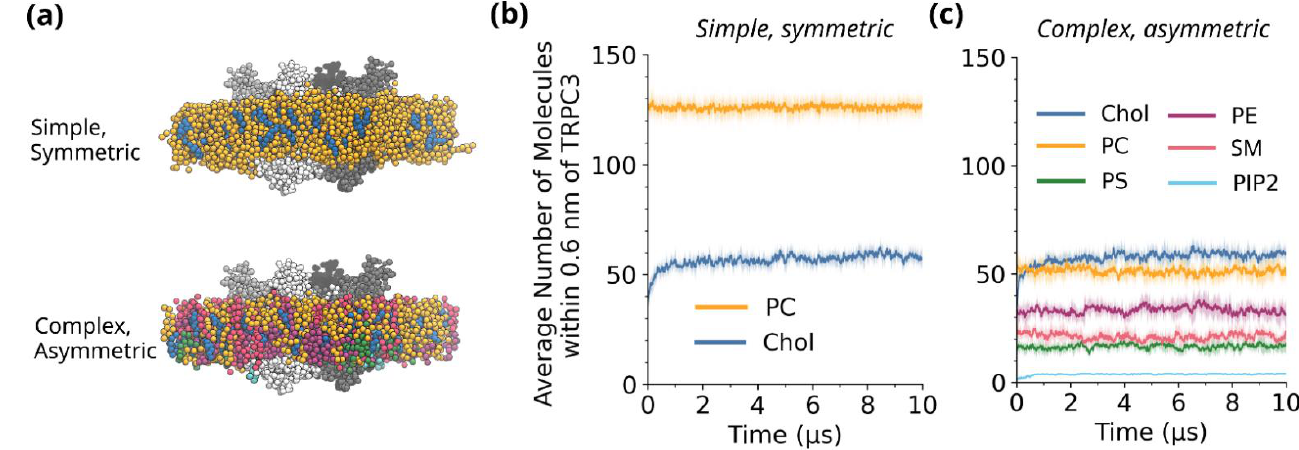
Figure 1. ( a ) Representative examples of the two membranes used in this study, a two-component symmetric membrane ( top ) and a six-component asymmetric membrane ( bottom ). The TRPC3 homotetramer is shown in greyscale, whilst the lipids are coloured according to the scheme in ( b , c ). ( b , c ) Number of lipid molecules within 0.6 nm of the TRPC3 homotetramer as a function of time, for the symmetric ( b ) and asymmetric ( c ) membranes. In dark is the mean averaged across four repeats; in light is the standard deviation. A window average of 20 ns has been applied.